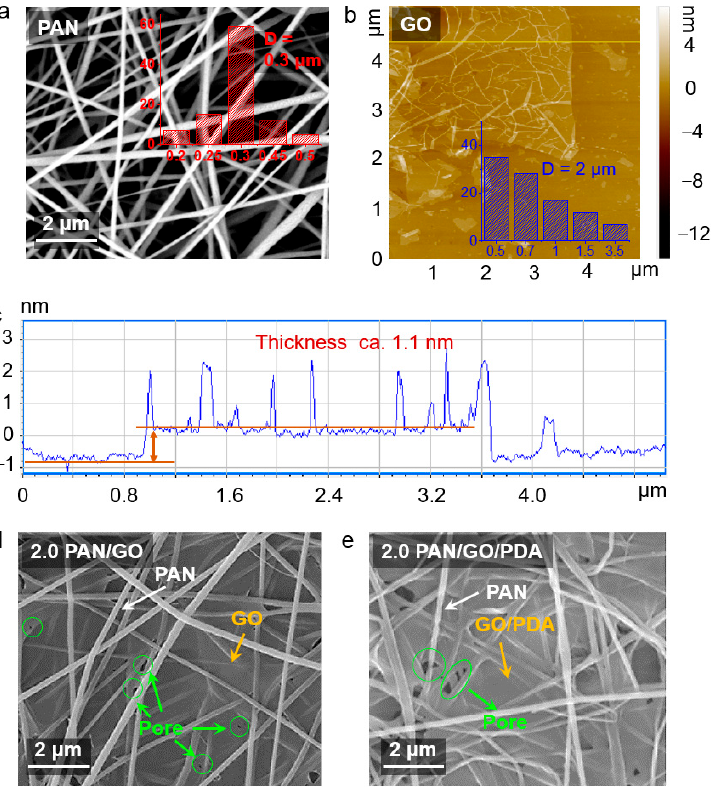
Figure 2. ( a ) SEM image of the PAN membrane. ( b ) AFM image of the GO sheets dispersed on silicon. ( c ) AFM height profile of the GO sheets. ( d ) SEM images of the 2.0 PAN/GO and ( e ) 2.0 PAN/GO/PDA membranes.